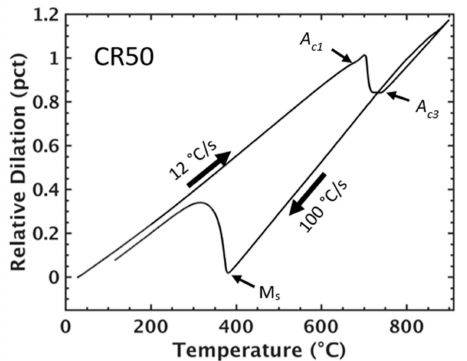
Figure 2. Dilation response of the CR50 condition during heating to 900 ◦ C followed by quenching to 30 ◦ C at 100 ◦ C /